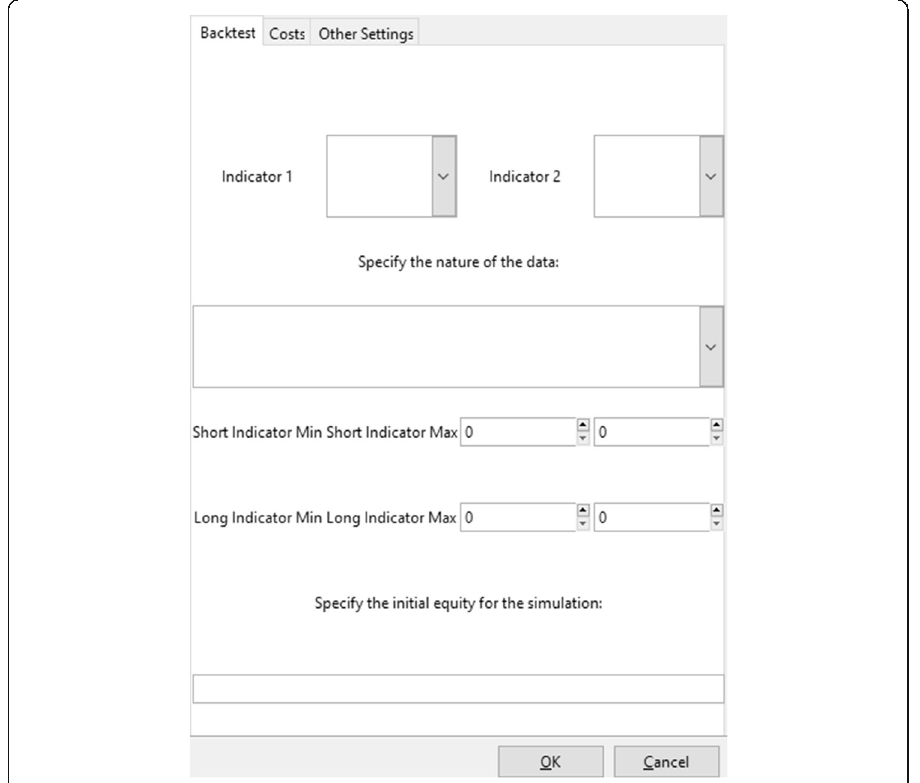
Fig. 1 Interface of Automated Trading